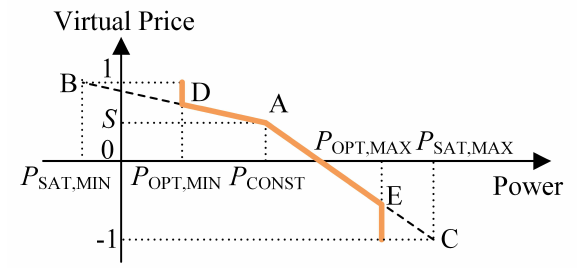
Figure 2. Demand curve of a continuous power